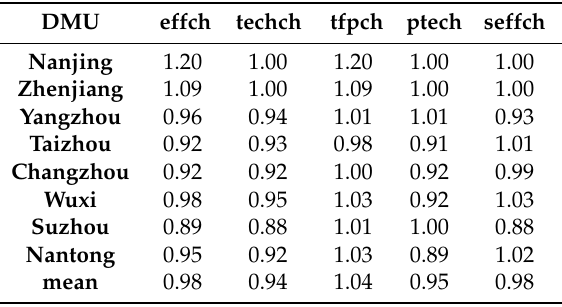
Table 5. Malmquist exponential decomposition results of EGE of the Yangtze River urban agglomeration from 2007 to 2016.